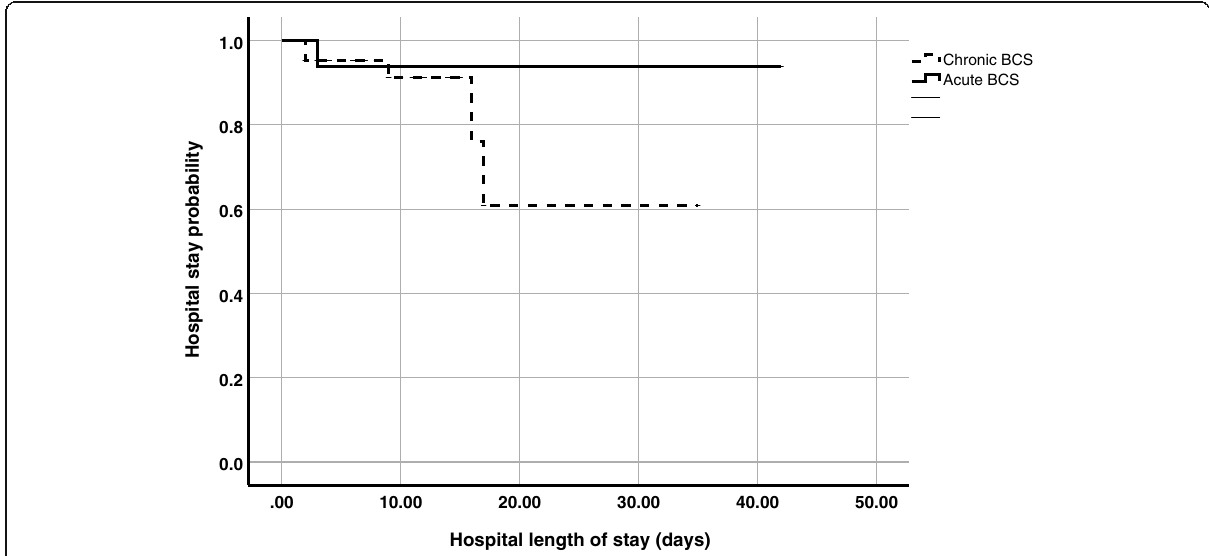
Fig. 1 Kaplan – Meier graph showing hospital length of stay curves for patients with acute and chronic Budd – Chiari syndrome